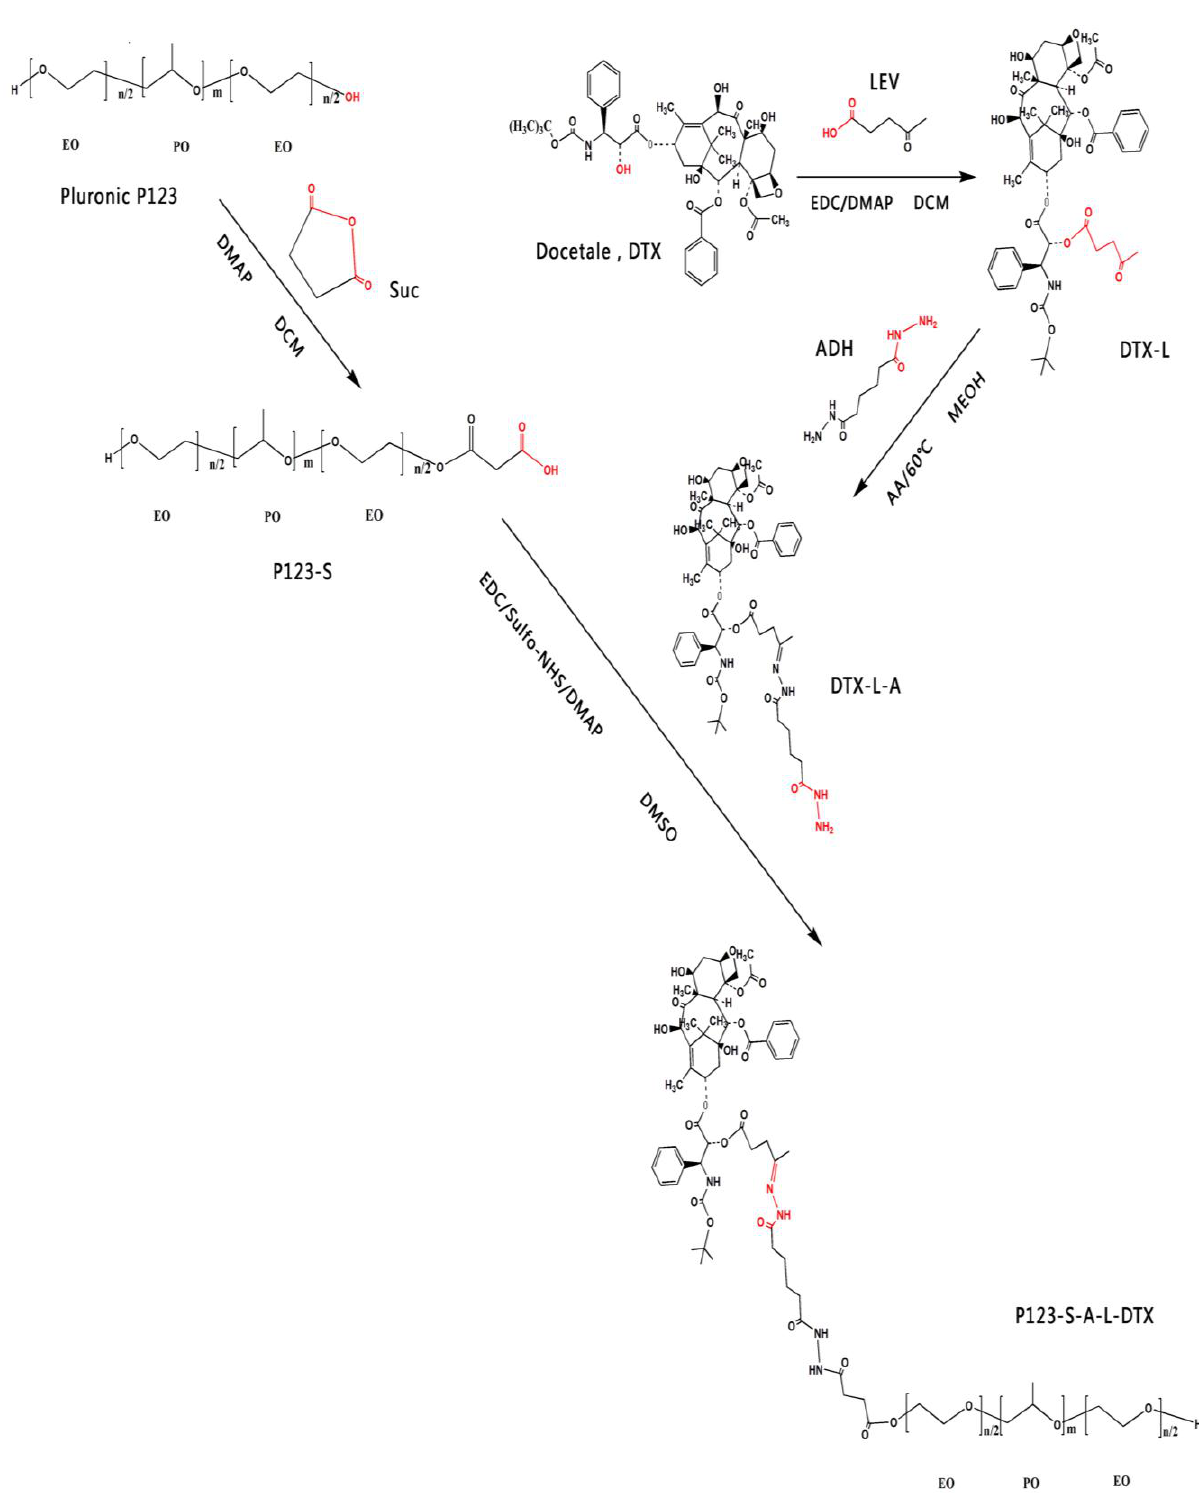
Figure 1. Synthetic routes used for the preparation of Pluronic